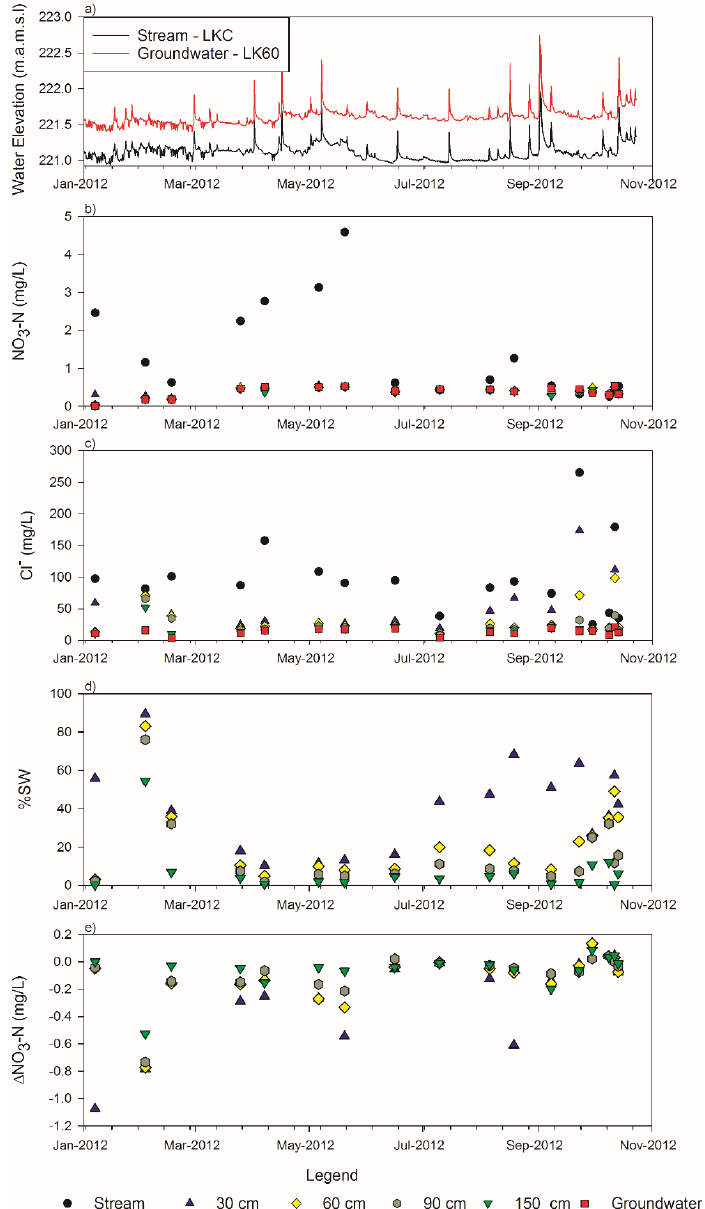
Figure 3. ( a ) Stream stage and groundwater elevation; ( b ) measured NO 3 -N (mg/L) in the stream, streambed, and wells; ( c ) measured Cl − (mg/L) in the stream, streambed, and wells; ( d ) calculated %SW ratios for the streambed depths; and ( e ) modeled Δ NO 3 -N values for the streambed depths.